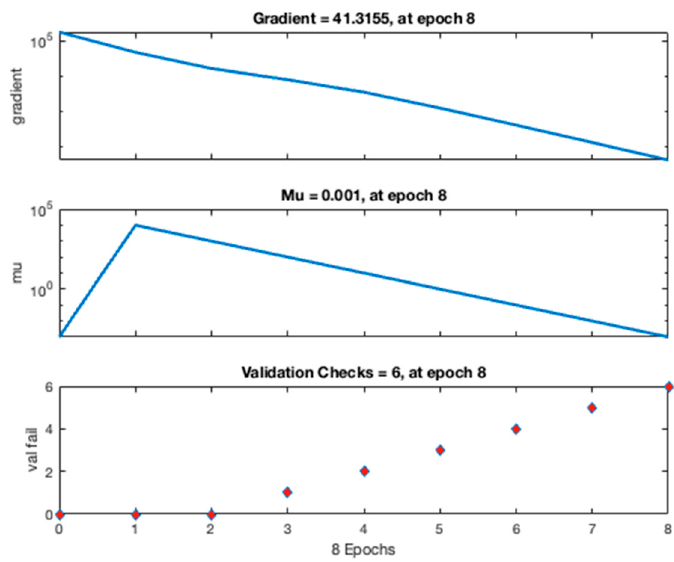
Figure 7. Mean Square Error (MSE) plot.